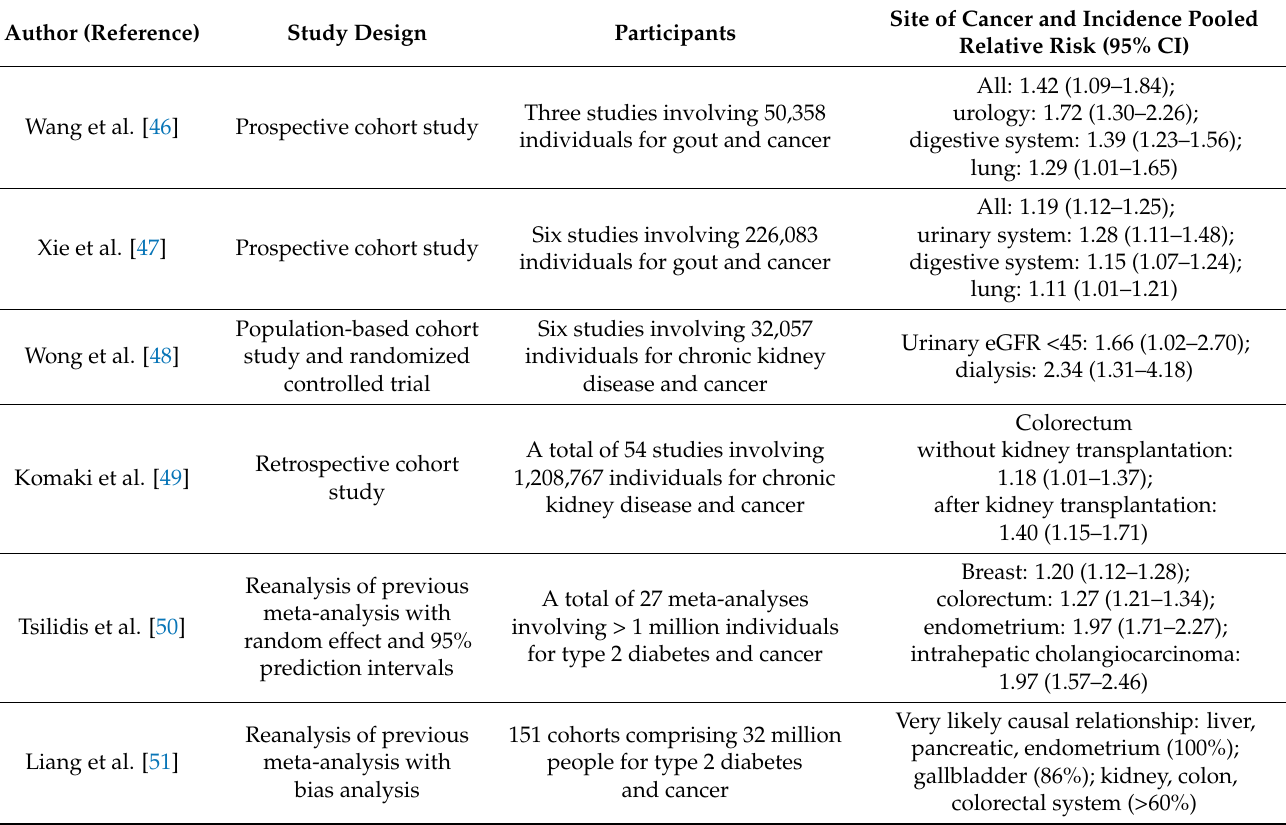
Table 3. Meta-analysis of epidemiological studies demonstrating that gout, chronic kidney disease, and diabetes increase cancer